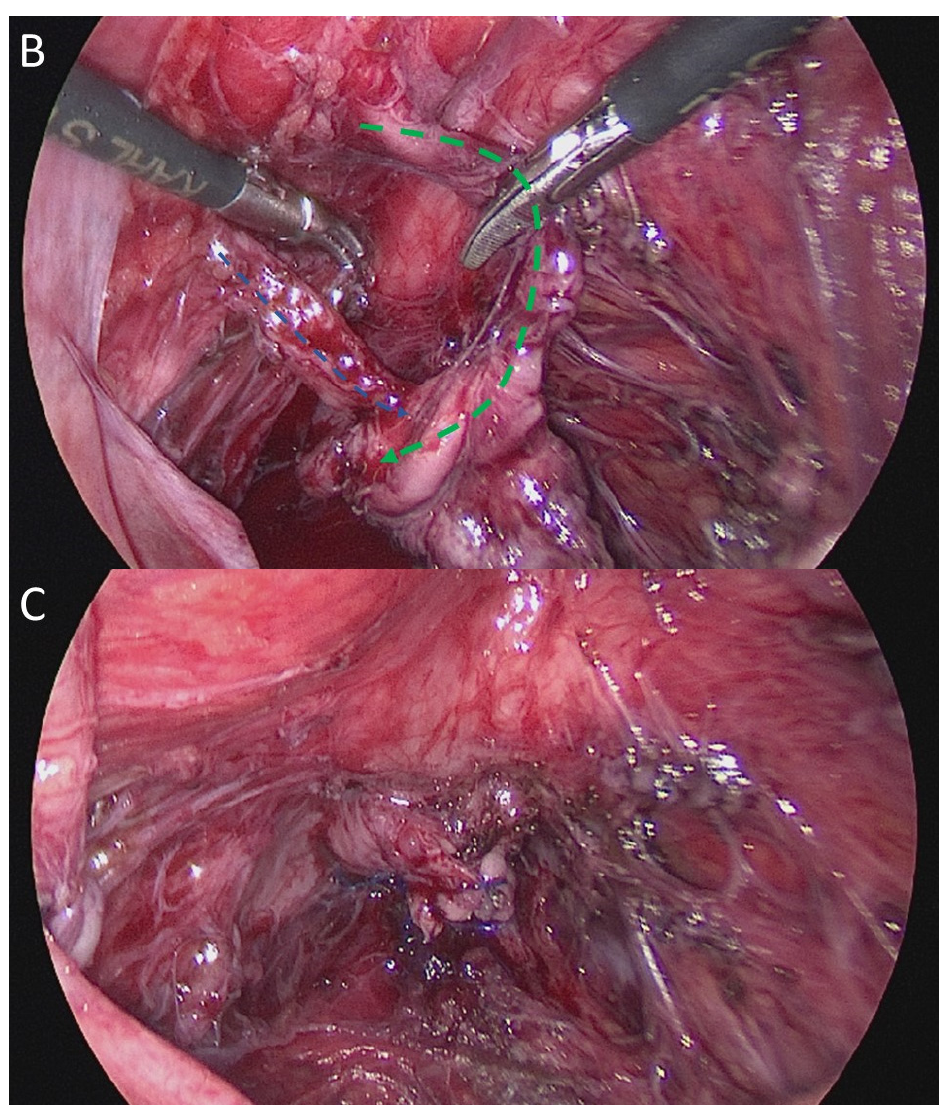
Figure 3. ( A ) Large utricle lesion was found between the bladder and rectum laparoscopically (arrow). ( B ) Crossover vas deferens from the right vas deferens to the left opening of the ejaculatory duct was observed (dotted green line arrow) and left vas deferens (dotted blue line arrow). ( C ) Utricle was completely resected.